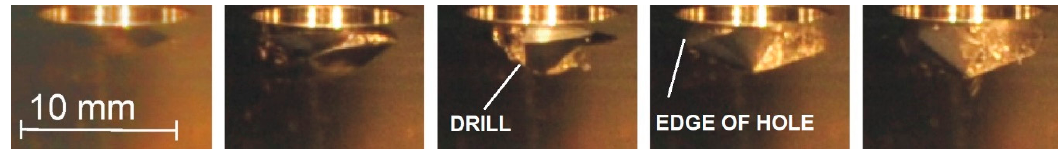
Figure 14. Camera frames showing subsequent stages of drilling with a factory drill.